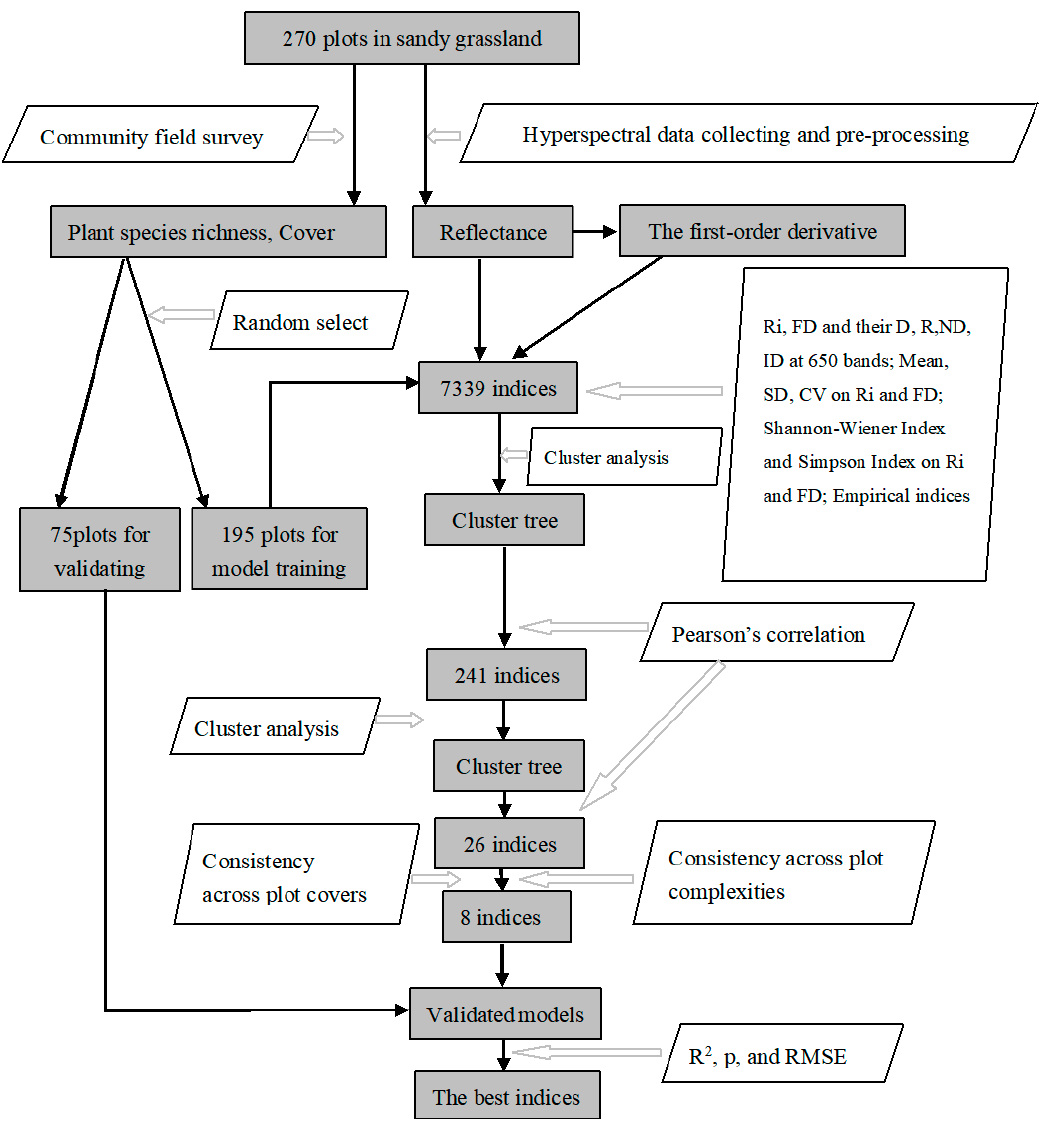
Figure 3. Flowchart of the analysis procedure of identifying the best hyperspectral indices to estimate plant species richness. See the text (section: Development hyperspectral indices) for full names of abbreviations used in the figure.